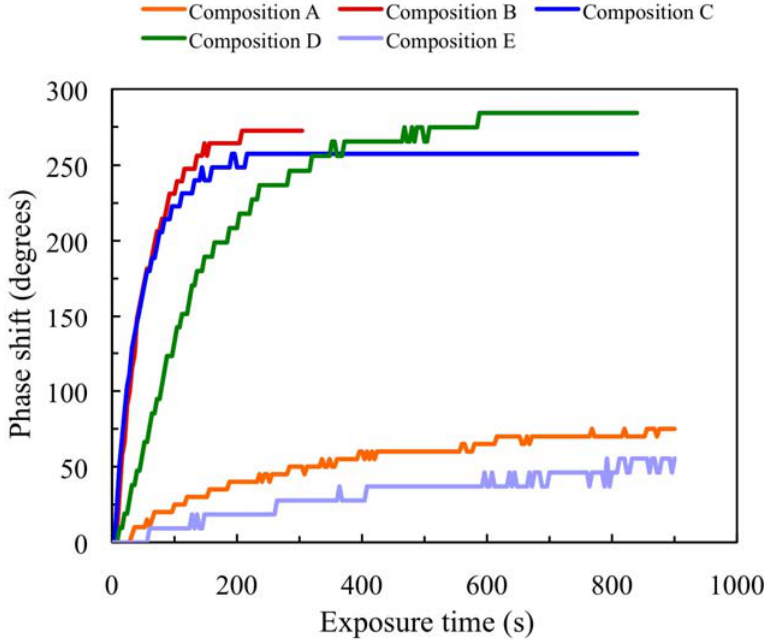
Figure 2. Phase shift as a function of exposure time in transmission experiments for photopolymer compositions A, B, C, D and E.